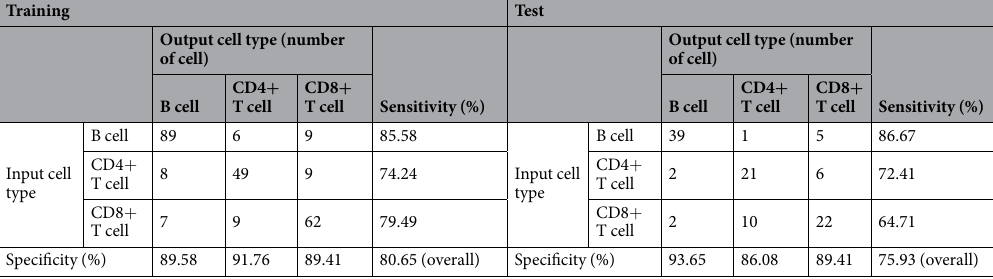
Table 3. Detailed performance of the three lymphocyte cell types classifiers. The identification accuracy and its sub-parameters, sensitivity and specificity, were also